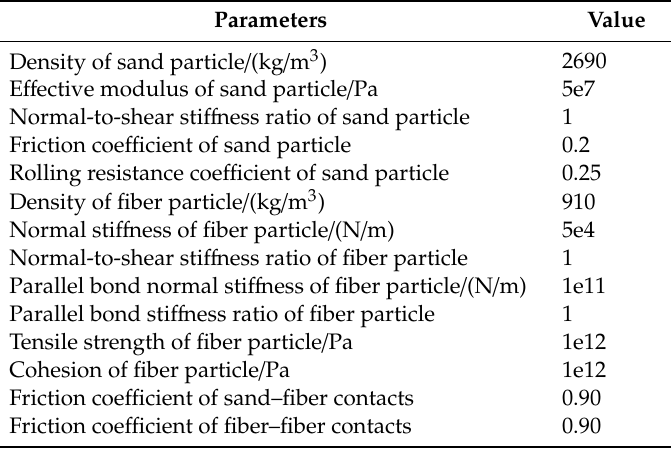
Table 1. Microscopic parameters for DEM simulation.